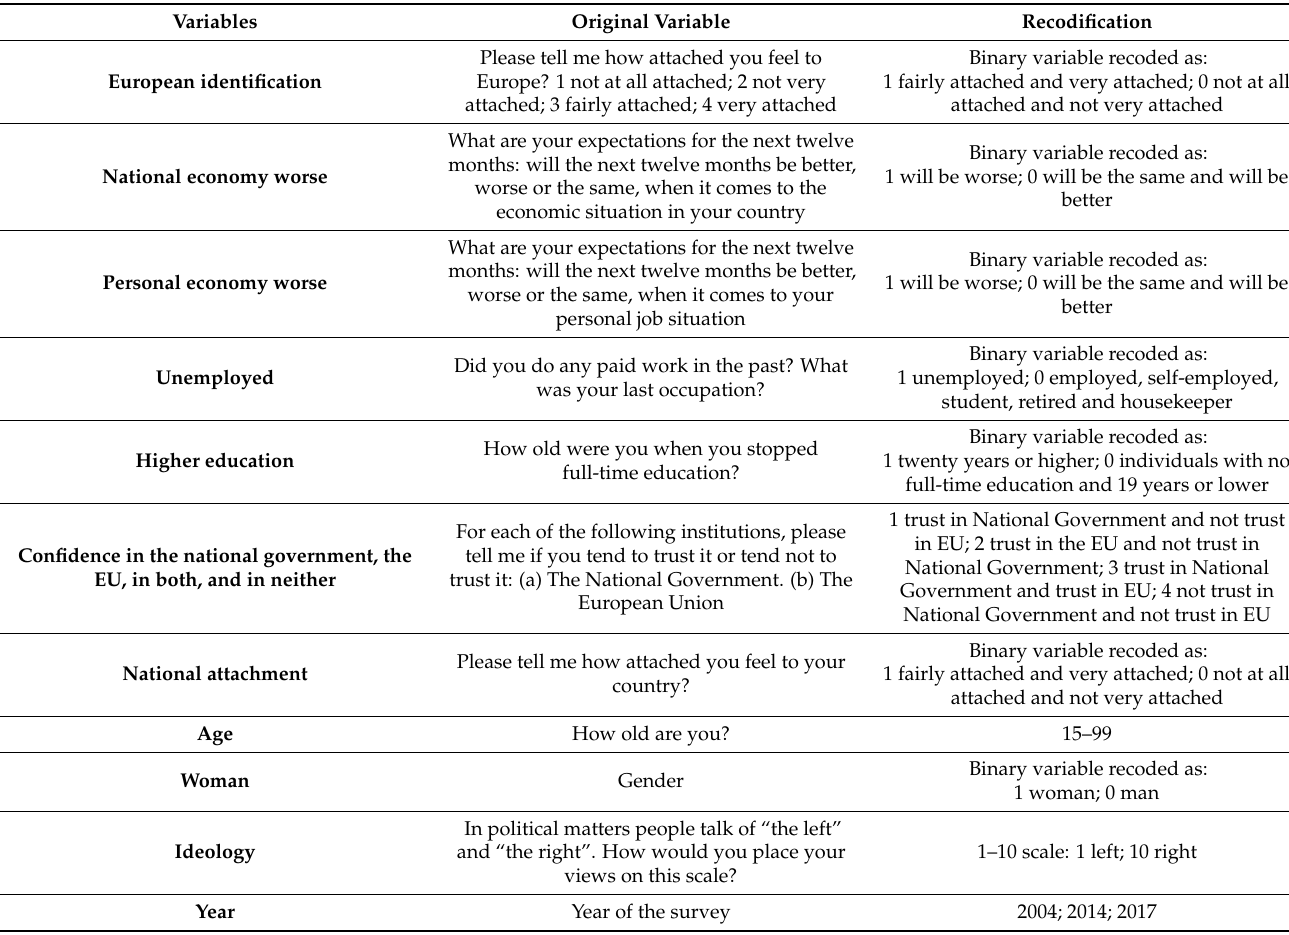
Table A1. Description and measurement of the variables.